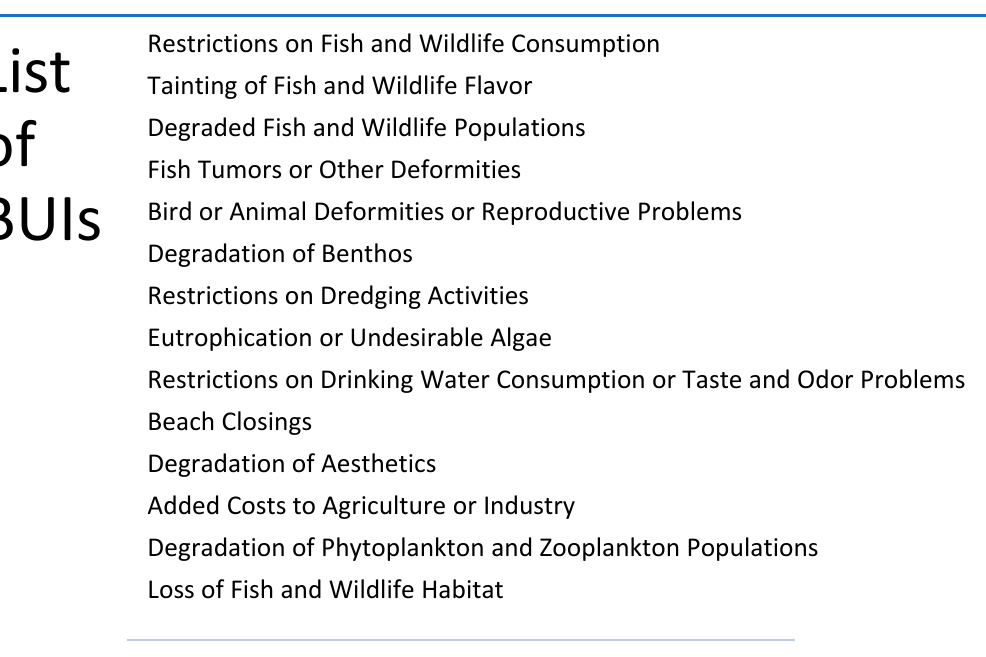
Figure 1. List of all Beneficial Use Impairments.